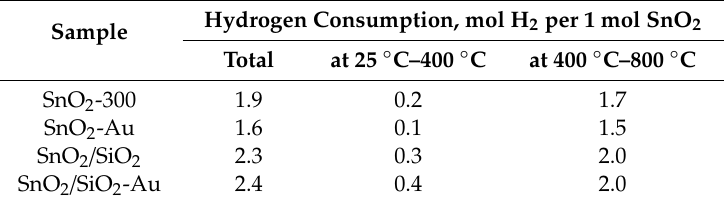
Figure 3. Temperature dependences of hydrogen consumption rate during reduction of SnO 2 -300, SnO 2 -Au, SnO 2 / SiO 2 and SnO 2 / SiO 2- Au samples. Table 3. TPR-H 2 measurement results.